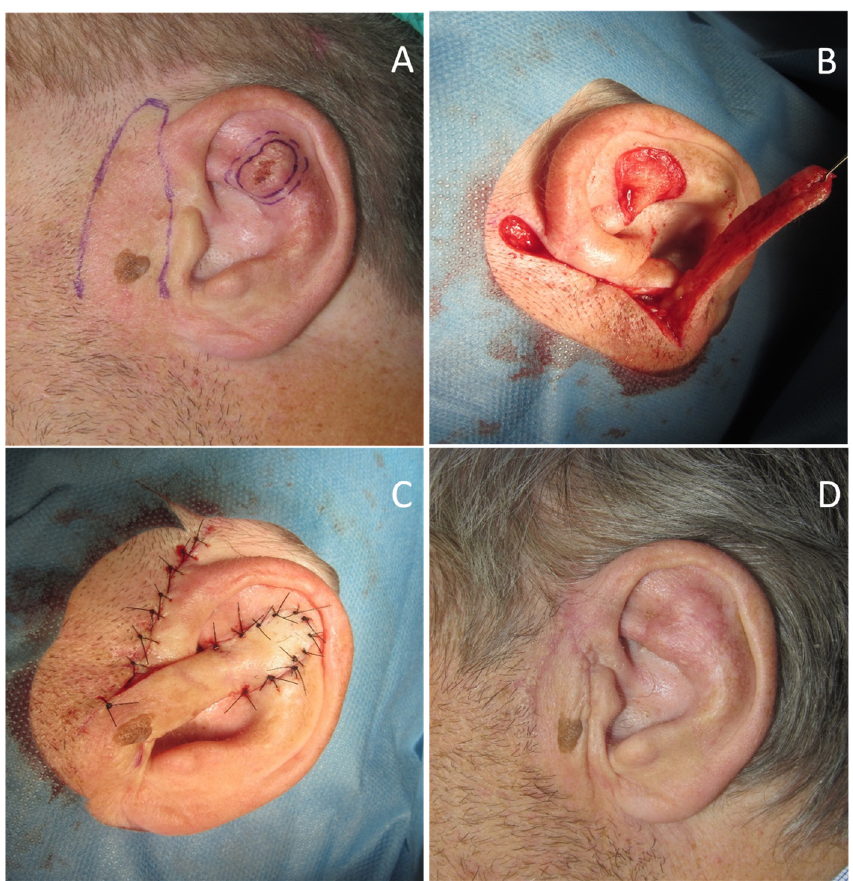
Figure 3. Histologic findings. Invasive, well-differentiated squamous cell carcinoma: keratinizing tumor infiltrating into the dermis (Hematoxylin and eosin, 2.5×).